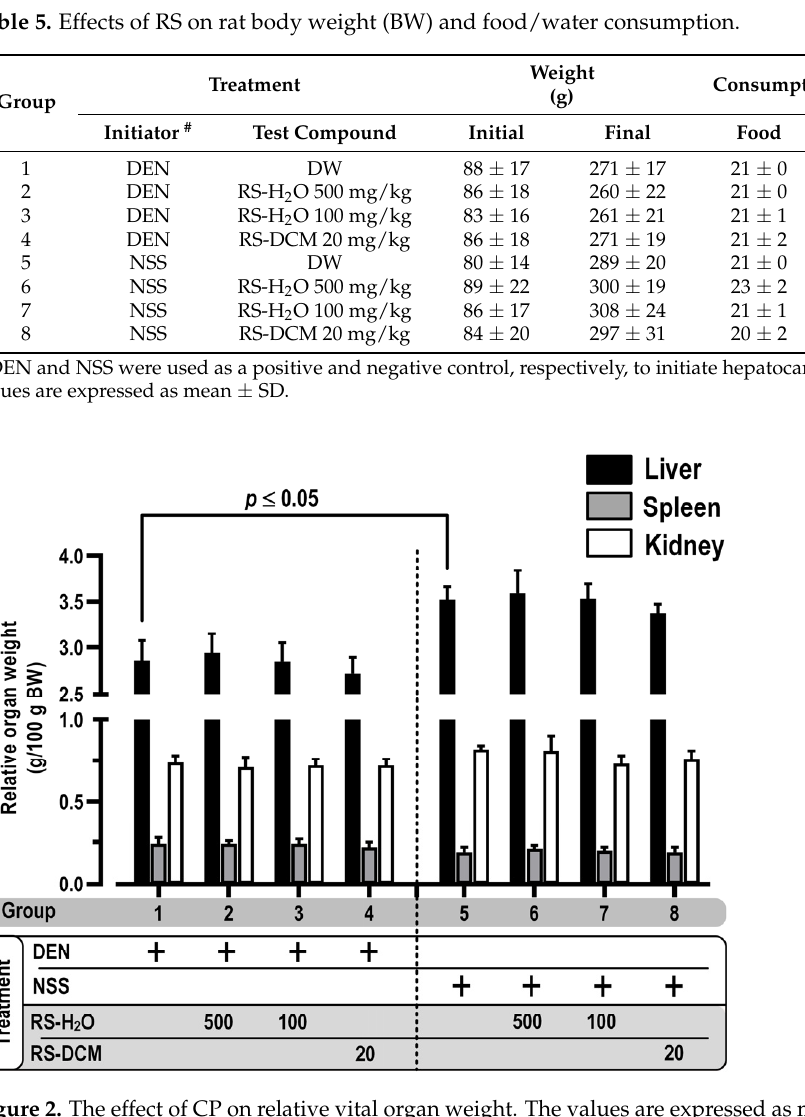
Figure 3. The e ff ect of RS on serum ALT level. The values are expressed as mean ± SD. The data were distributed normally (Shapiro–Wilk: p > 0.05) and were analyzed for statistical signi fi cance using one-way ANOVA with LSD’s post hoc test. RS dosage unit is mg/kg BW. 3.3. E ff ect of RS on GST - P Positive Foci The e ff ect of RS on hepatocarcinogenesis was determined from GST-P foci, a characteristic sign to indicate a preneoplastic lesion in the rat liver. Results showed that GST-P positive foci were observed after DEN administration, whereas NSS treatment found no positive trait. Co-administration of RS-H 2 O (500 mg/kg) or RS-DCM (20 mg/kg) with DEN signi fi cantly reduced GST-P positive foci expression (both GST-P number and area) (Figure 4A,B). It was evidence that RS extract potentially a tt enuated hepatocarcino- genesis.